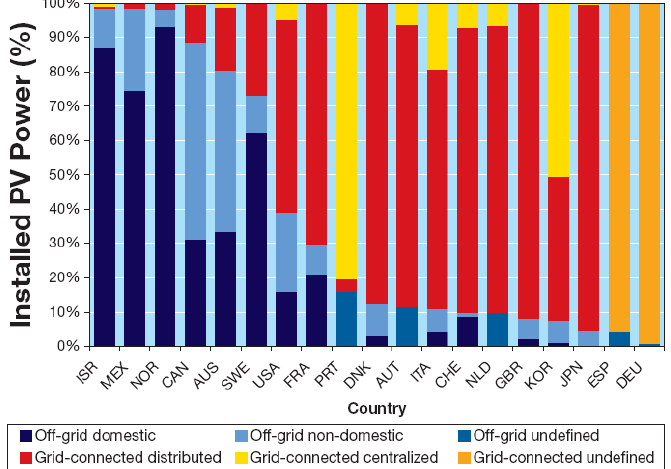
Figure 64. Type of installation as a percentage of total PV capacity. © 2008 OECD/IEA, reproduced from [54] with